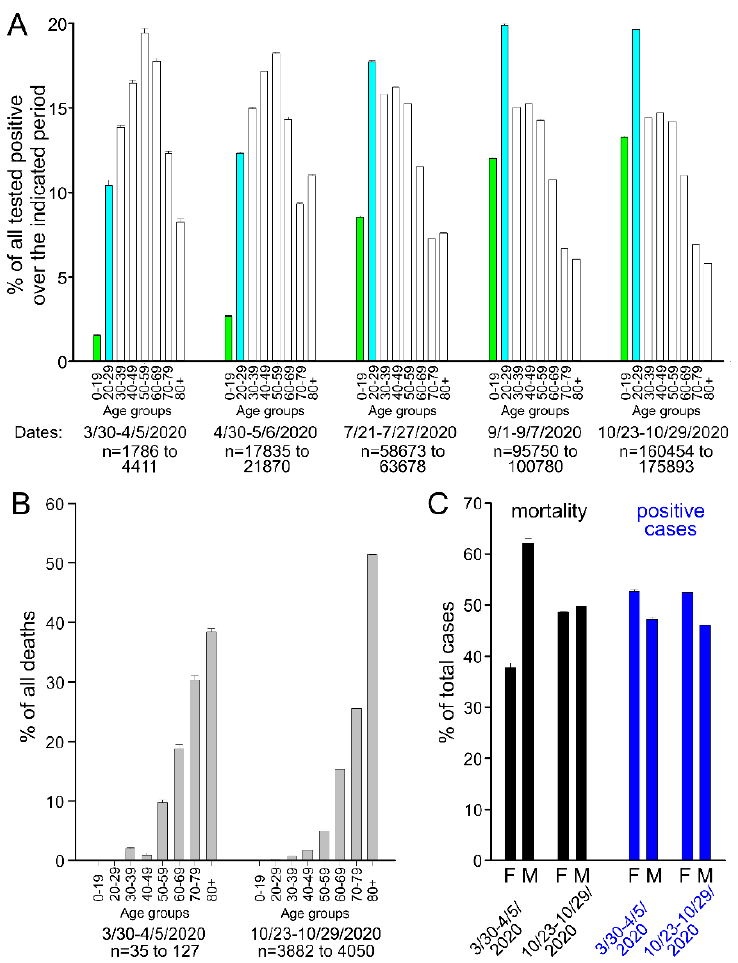
Figure 1. SARS-CoV-2 infection demographics for the state of Indiana from publicly available sources (https: // www.regenstrief.org / covid-dashboard / and https: // www.coronavirus.in.gov / ). In each case, an average over a seven-day period is provided. ( A ) The number of positive cases during the indicated periods. One Way Repeated Measures Analysis of Variance ( p < 0.001) for 0–19 and 20–29 age groups. ( B ) Mortality data at the two indicated time periods, which were averaged over a seven-day period. ( C ) Gender demographics for the mortality and positive case data, which were averaged over a seven-day period.